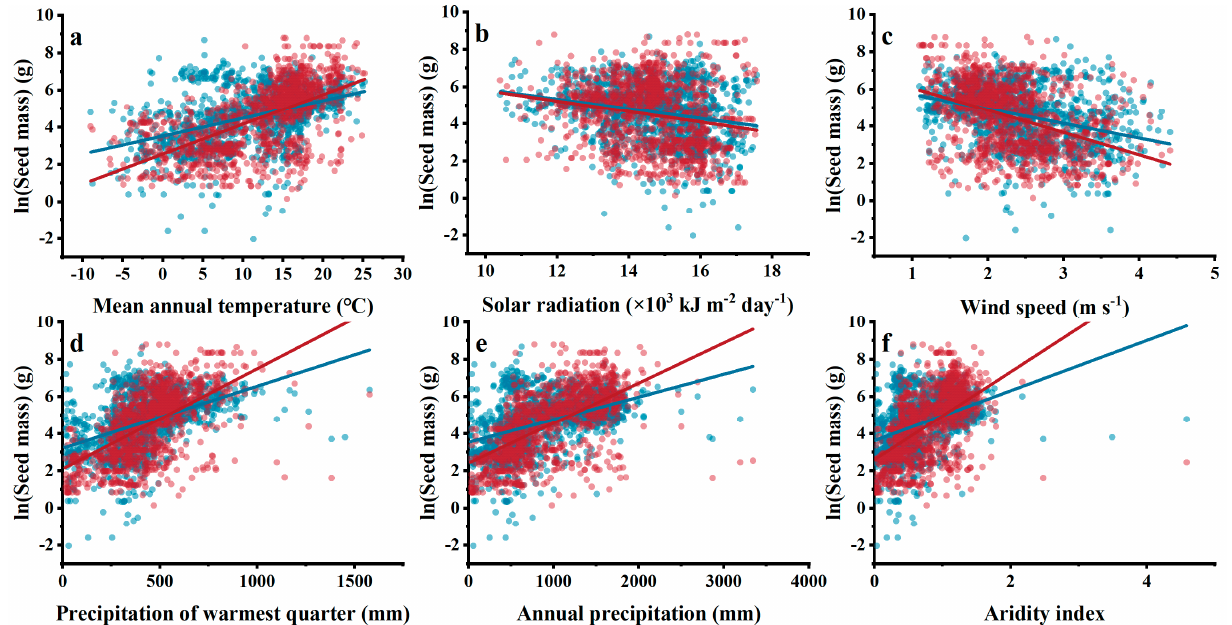
Figure 4. Relationships between the seed mass of woody plants and ( a ) Mean annual temperature; ( b ) Solar radiation; ( c ) Wind speed; ( d ) Precipitation of the warmest quarter; ( e ) Annual precipitation and ( f ) Aridity index. The red dots and fitted straight line indicate the gymnosperms, and the blue dots and fitted straight lines indicate the angiosperms. The solid lines indicate significant linear regression ( p < 0.01).